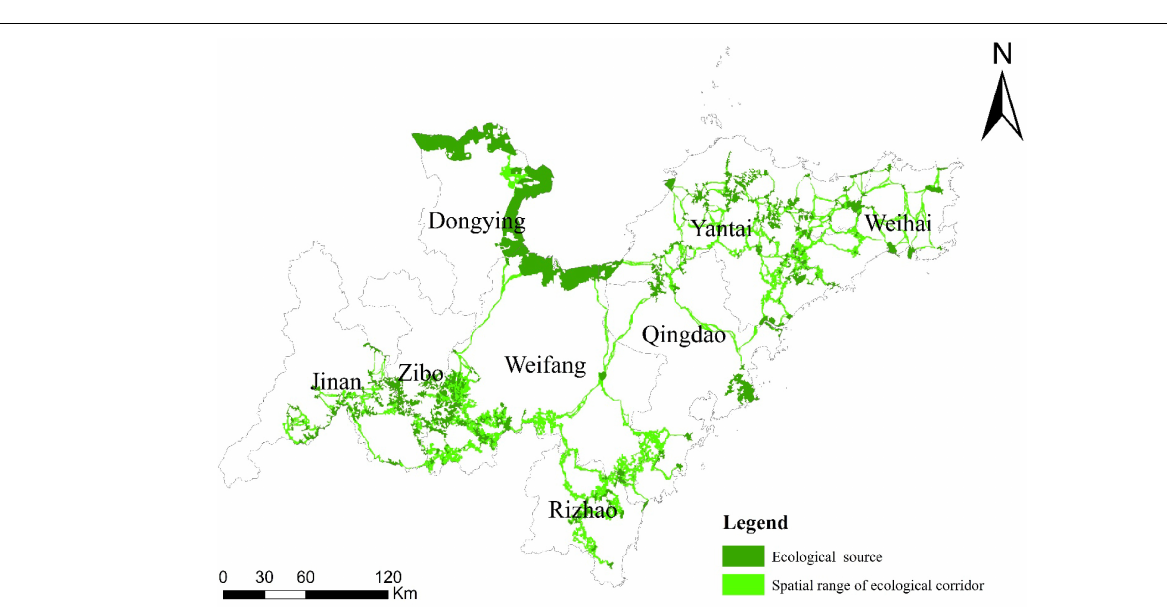
corridors was 5872.86 km 2 . In general, the average width